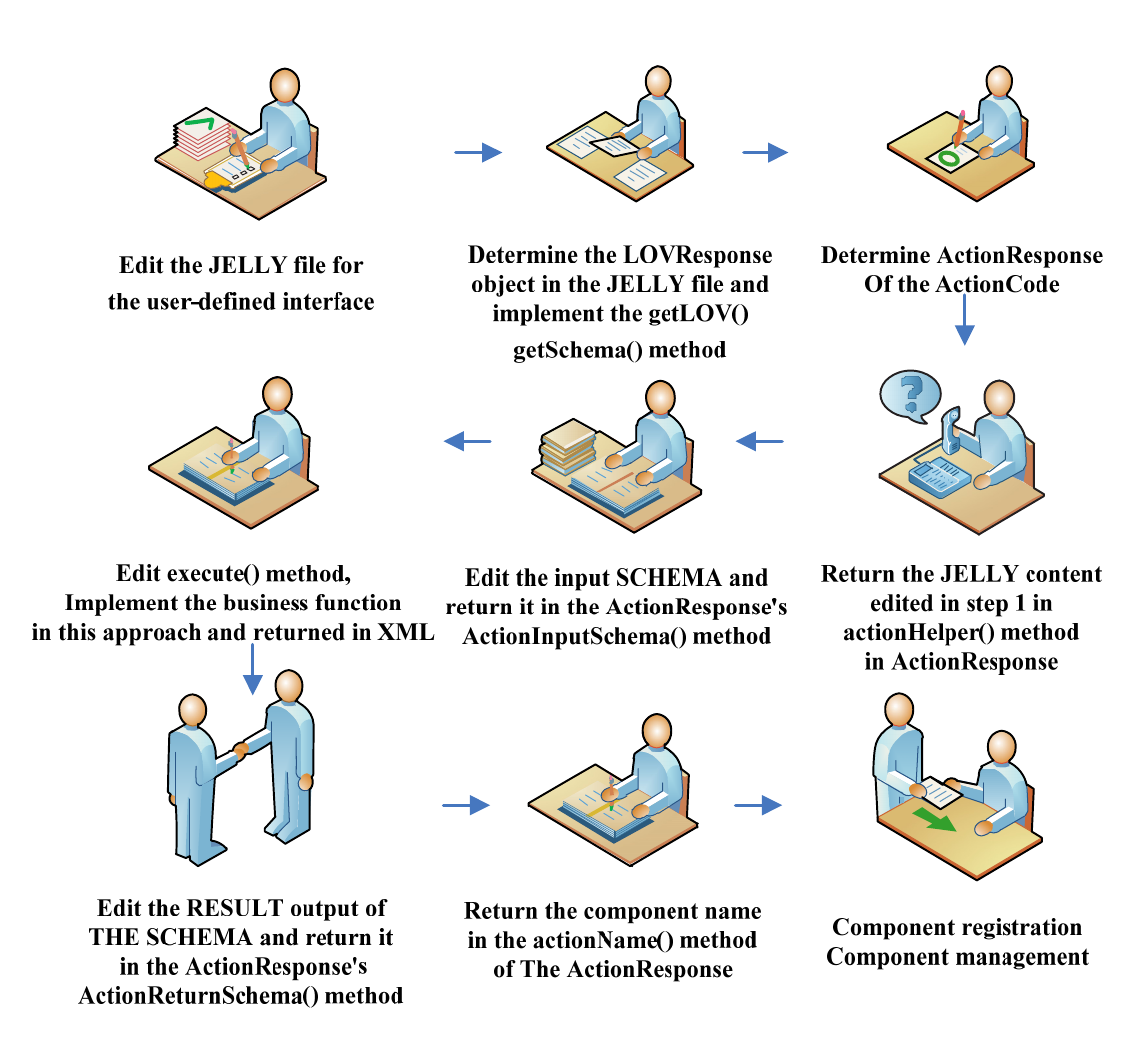
Figure 4. Development process diagram.